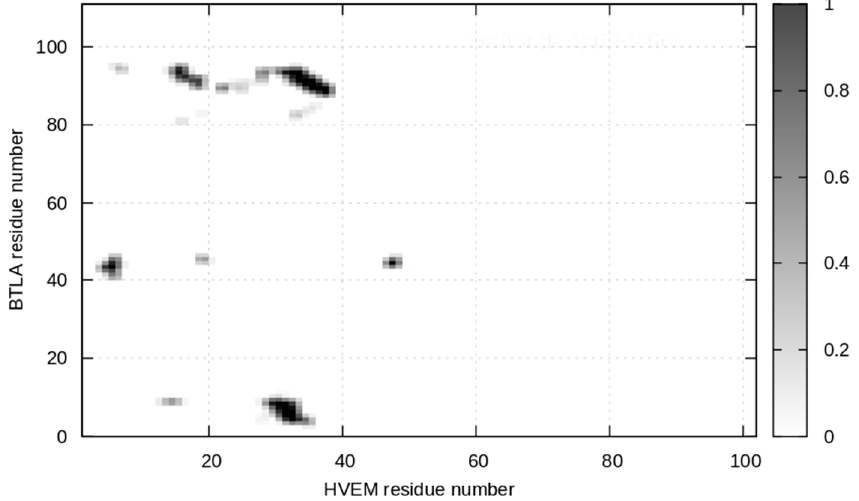
Figure 1. The contact map obtained for the interface between BTLA and HVEM from the crystal structure (PDB code: 2AW2). The gray scale uses black to indicate the highest contact value and white to indicate the smallest contact value.